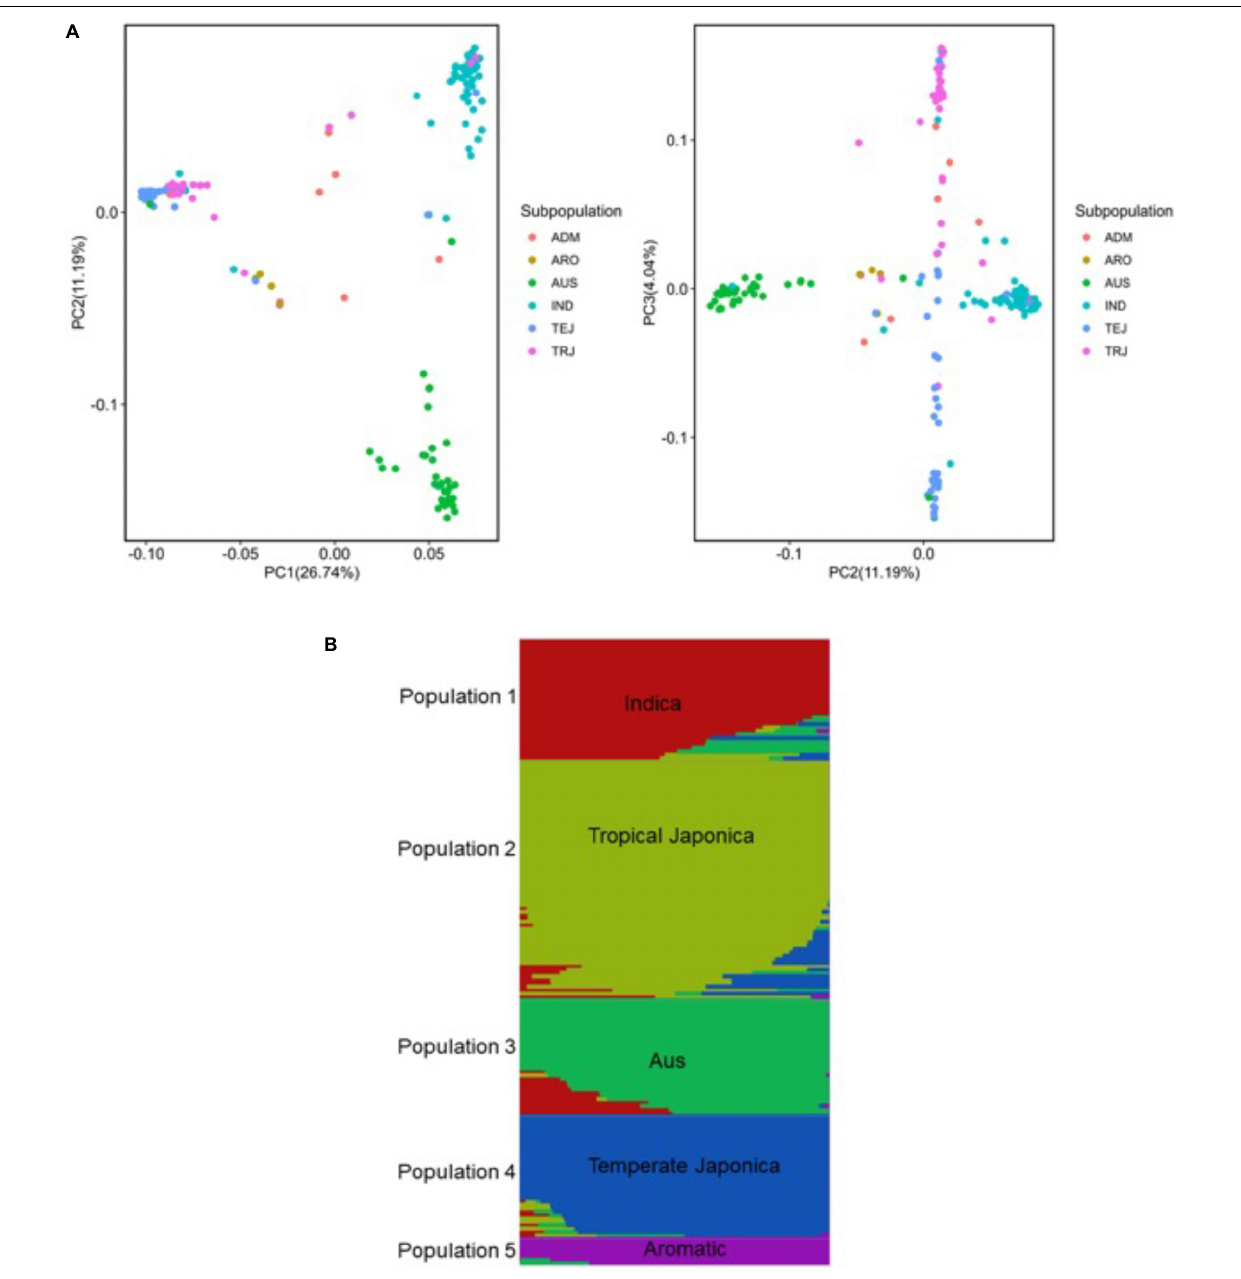
highly significant associated SNPs above the threshold of − log 10 p (1e −